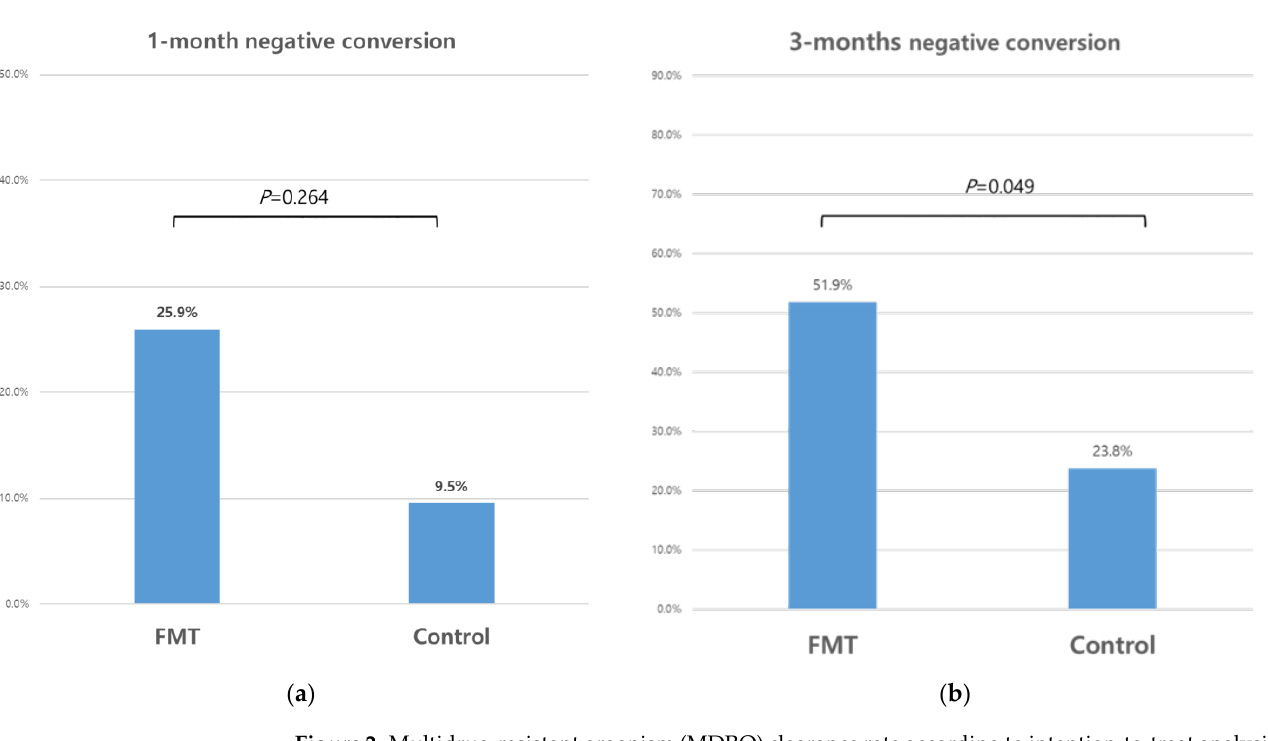
Figure 2. Multidrug-resistant organism (MDRO) clearance rate according to intention-to-treat analysis following fecal microbiota transplantation (FMT). ( a ) 1-month negative-conversion rate ( b ) 3-month negative-conversion rate.